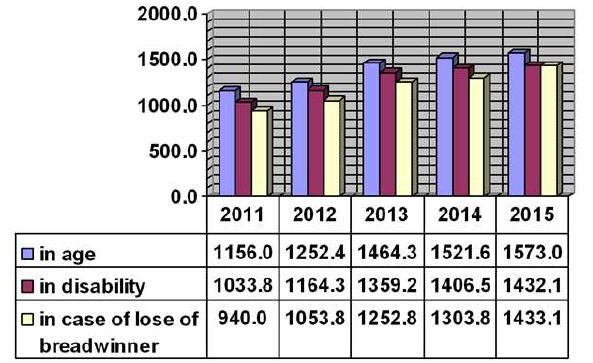
Fig. 2.2. Dynamics of increase of pension payments according to their types in Ukraine in the period of 2011- 2015,